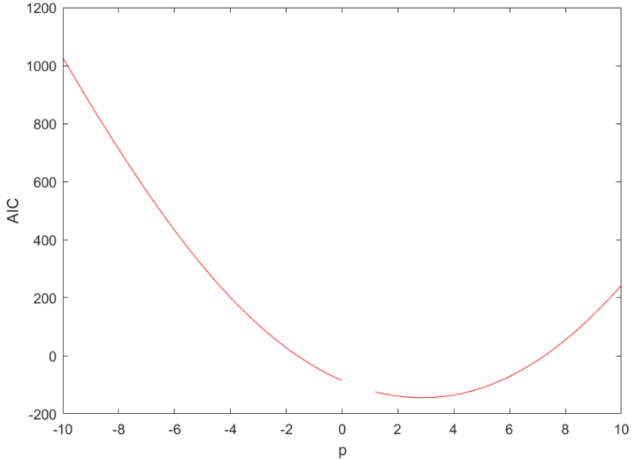
Figure 4. The AICs based on different parameter p